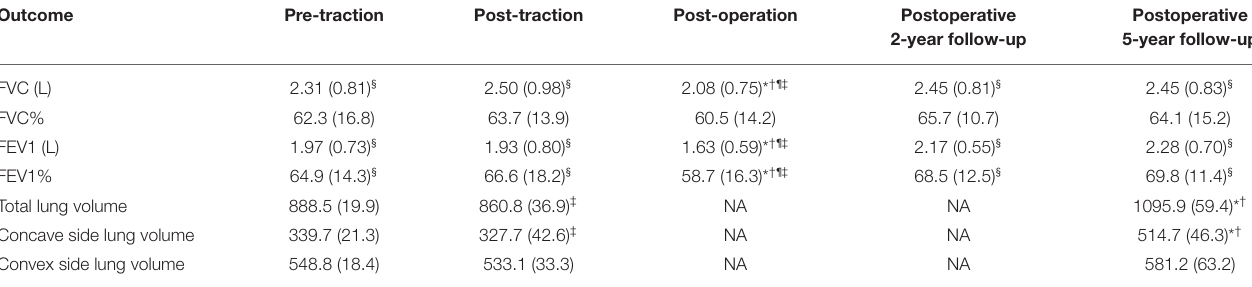
TABLE 3 | Spirometric results and lung volume